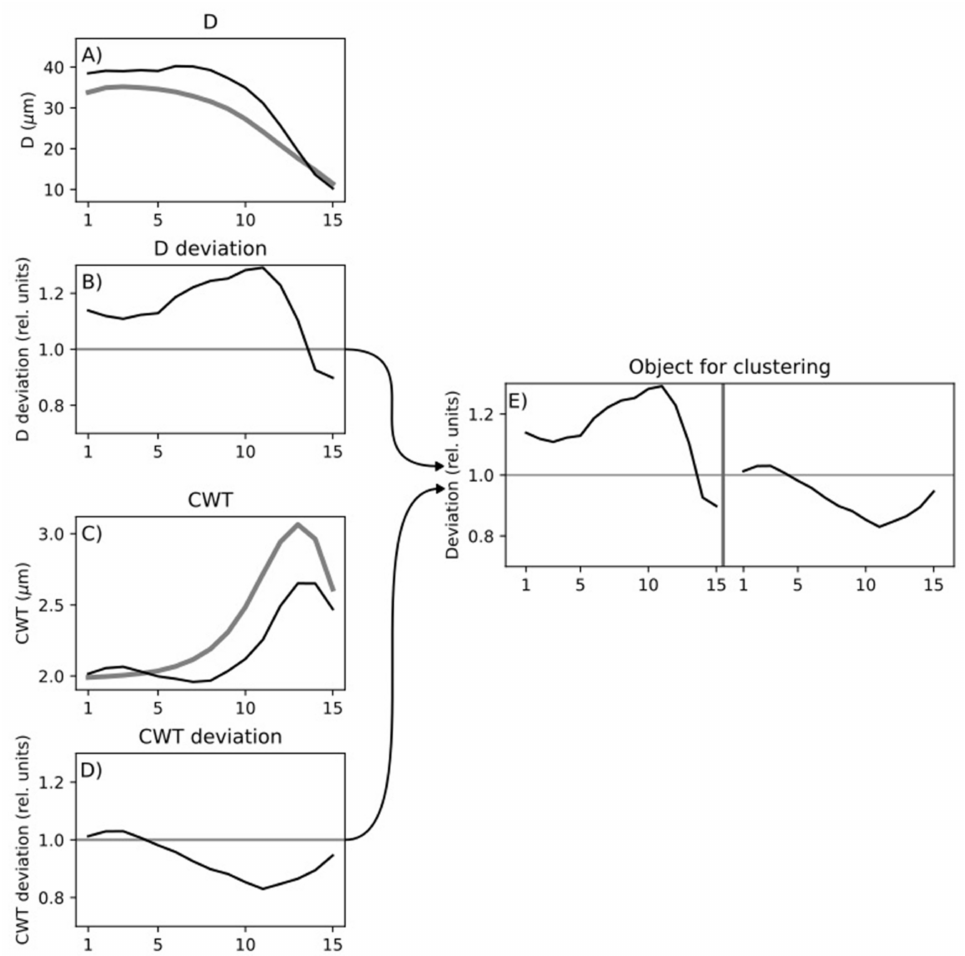
Figure 3. Average tracheidogram of the radial cell diameter D for 7 trees in 2000 (black solid curve) and a general mean long-term tracheidogram of D over 1813–2018 (grey solid line) ( A ); relative deviation of the average D tracheidogram in 2000 to the general mean ( B ); average tracheidogram of the cell wall thickness CWT for 7 trees in 2000 (black solid curve) and total mean tracheidogram of CWT over 1813–2018 (grey solid line) ( C ); relative deviation of the mean CWT tracheidogram in 2000 to the total mean ( D ); combined relative deviation for D and CWT (15 values of D and 15 values of CWT considered as a 30-dimensional vector) in 2000 ( E